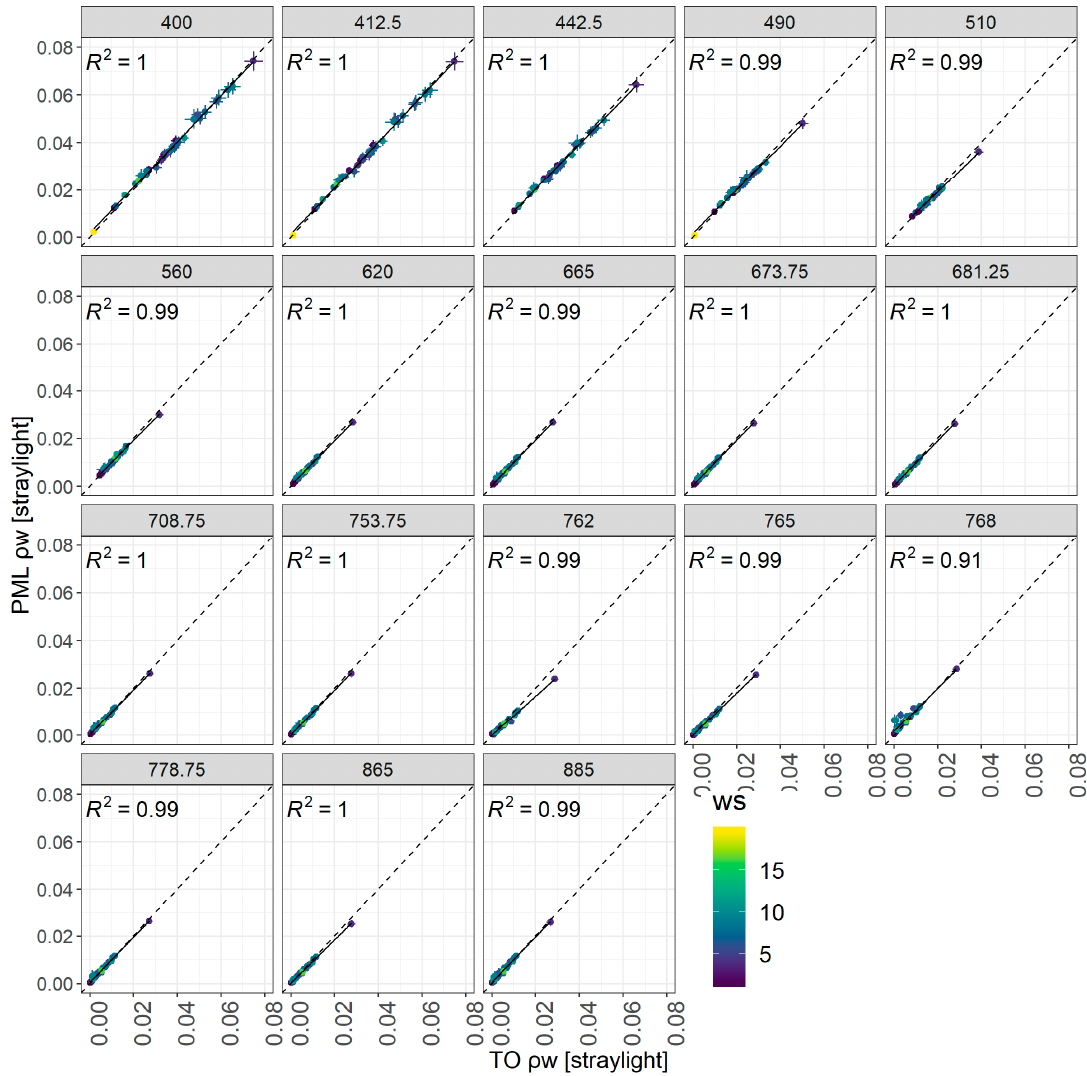
Figure A4. Comparison between TO and PML ρ w ( λ ) after straylight correction at OLCI’s Figure A4 . Comparison between TO and PML 𝜌 (cid:3050) (𝜆) after straylight correction at OLCI’s bands.